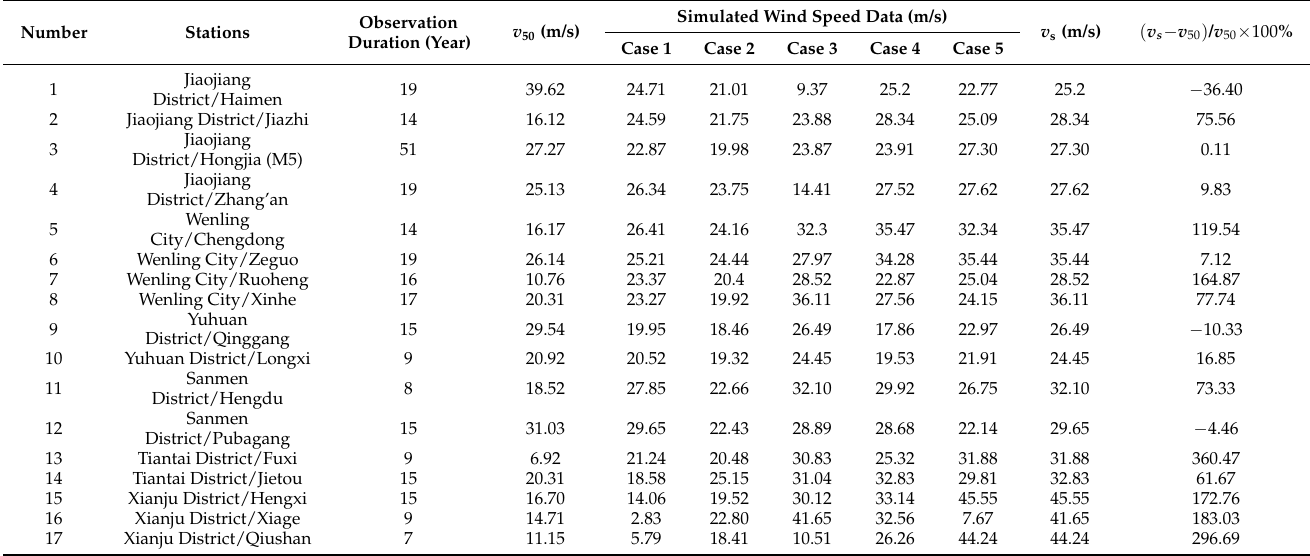
Table 8. Comparison of the simulated and reference wind speeds at the 17 meteorological stations in Taizhou City.